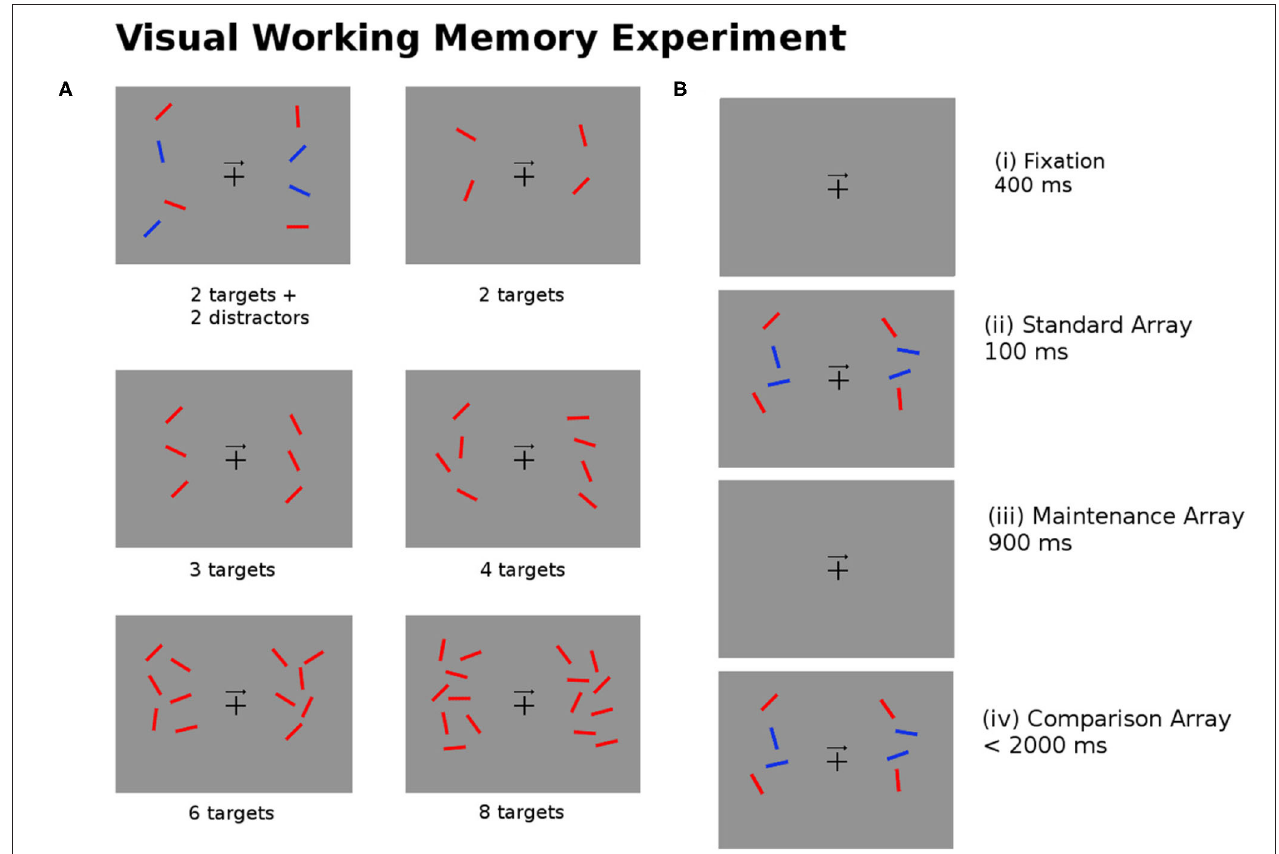
FIGURE 4 | (A) The experimental task required subjects to recall the position of the red bars (targets) on the left or right side of the image as indicated by the arrow in the center of the image. The six images show examples of the test image for different numbers of targets and distractors (blue bars). (B) For every trial of the experiment the subjects are shown (i) a fixation image (400 ± 200 ms); (ii) the standard array to be memorized (100 ms); (iii) the maintenance image (900 ms); (iv) the comparison array, at which point subjects are asked to respond within 2,000 ms if the targets in the comparison arrays match or mismatch the standard array (Pluta et al.,